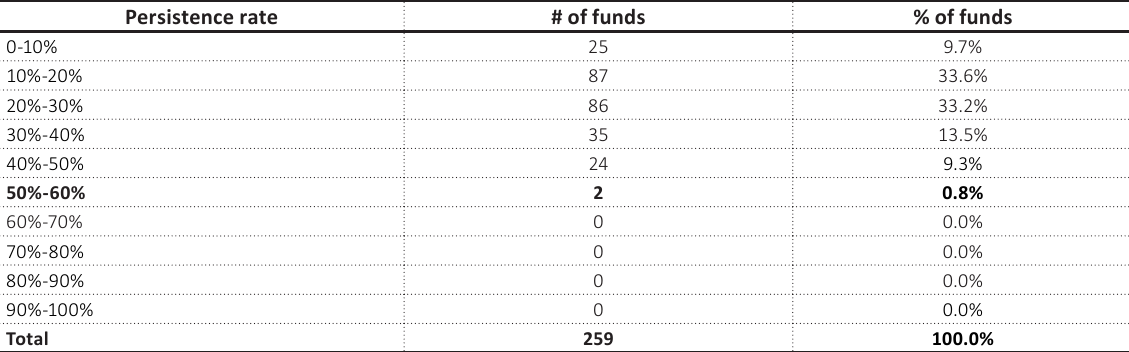
Table 8. Summary statistics of persistence rates in pension